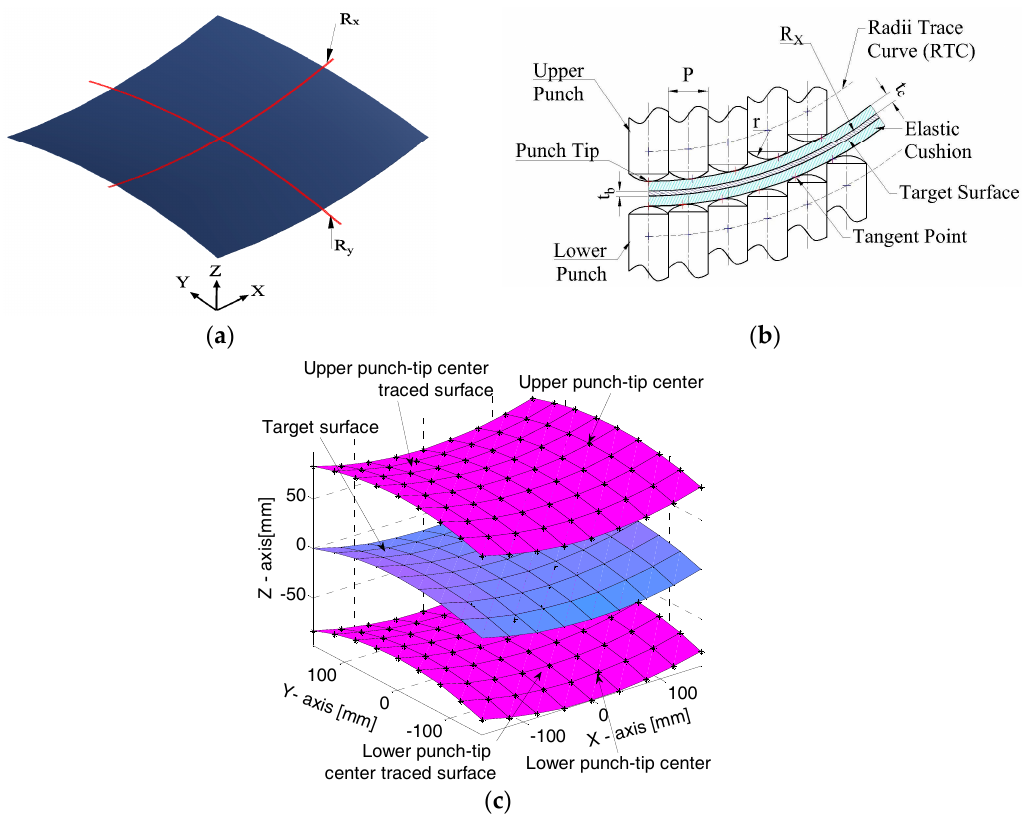
Figure 1. Saddle shape geometry model on multi-point dieless forming (MDF): ( a ) Target shape; ( b ) Punch placement in a two-dimensional view; ( c ) Positions of the lower and upper Radii trace curve (RTC) radii center traced surfaces.